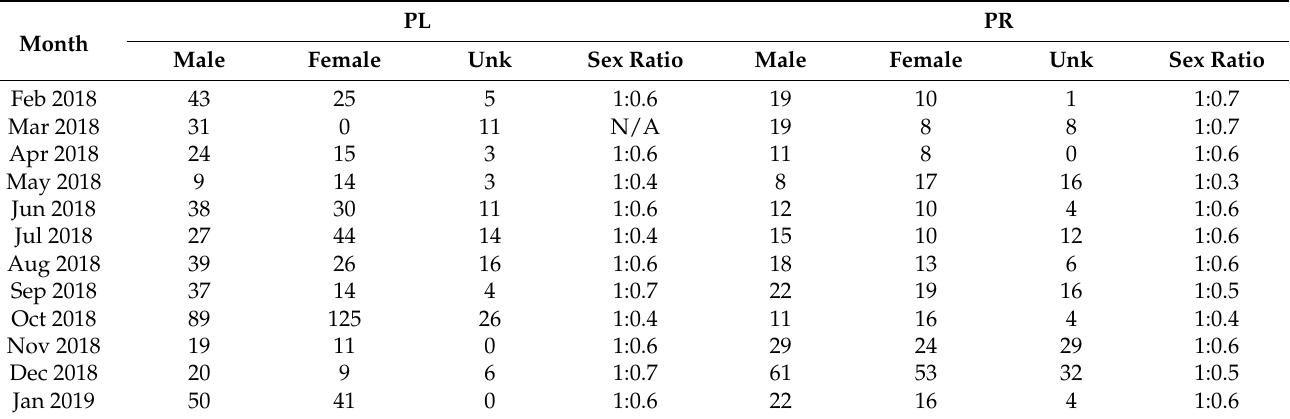
The abbreviation Unk means “unidentified sex”, which was due to our inability to catch the individual and measure it, although we were able to observe it within our sampling plots; N/A means “not analyzed”. The averages of body size parameters including weight (W) (F = 24.8, df = 1179, p = 0.001), carapace width (CW) (F = 28.3, df = 1179, p = 0.001) and carapace length